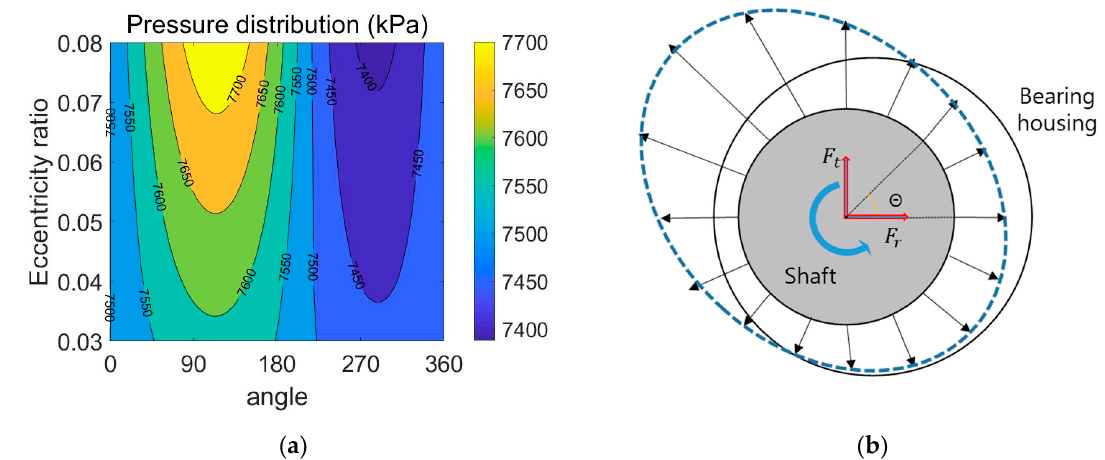
Figure 6. Pressure distribution around a rotating shaft: ( a ) 7.5 MPa, 30 °C CO 2 inlet and 30,000 rpm conditions with various eccentricity ratio. ( b ) description of fluid force exerted on the shaft caused by pressure distribution